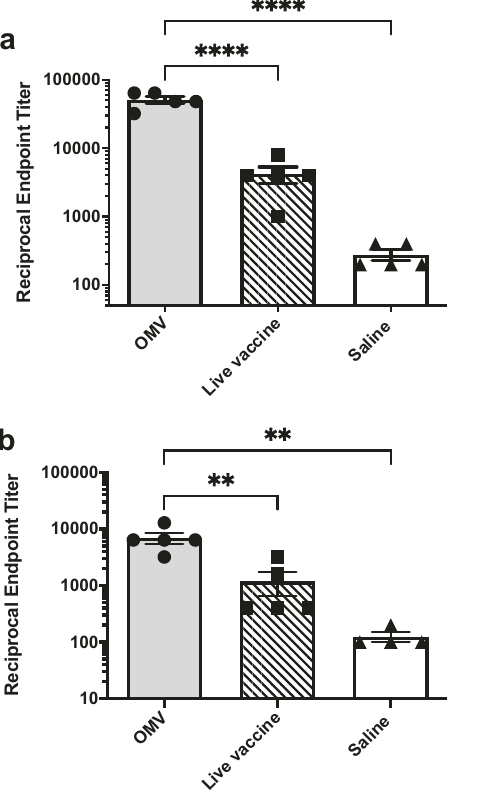
Fig. 4 OMV immunization induces higher titers of IgG than live vaccine. Mean reciprocal endpoint titers of serum IgG were determined for mice ( n = 5 per group) immunized with M9 OMVs, live-attenuated Bp82 vaccine, or sham by ELISA using microtiter plates coated with a M9 OMVs or b heat-inactivated M9-grown Bp82 bacteria (* p < 0.05, ** p < 0.01, *** p < 0.001, **** p < 0.0001. Statistical analysis was performed using one-way ANOVA with Tukey ’ s multiple comparisons test. Results are representative of two independent experiments. Fig. 5 Immunization with M9 OMVs induces memory CD4 and